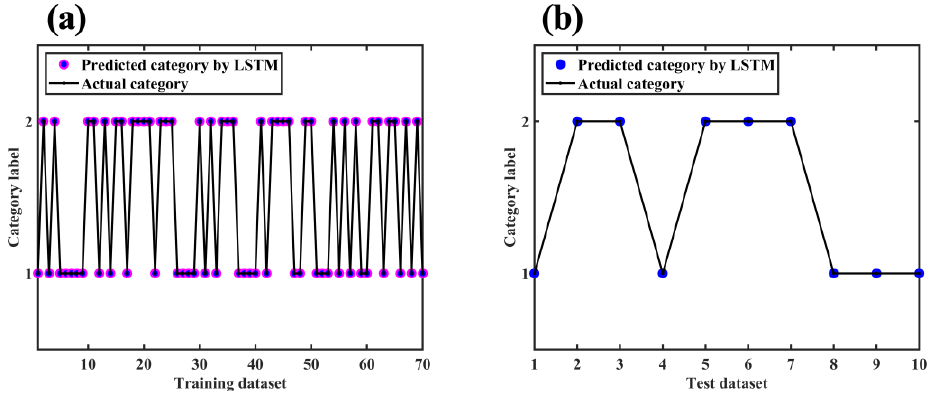
Figure 14. Classification results for ( a ) training dataset and ( b ) test dataset with LSTM.